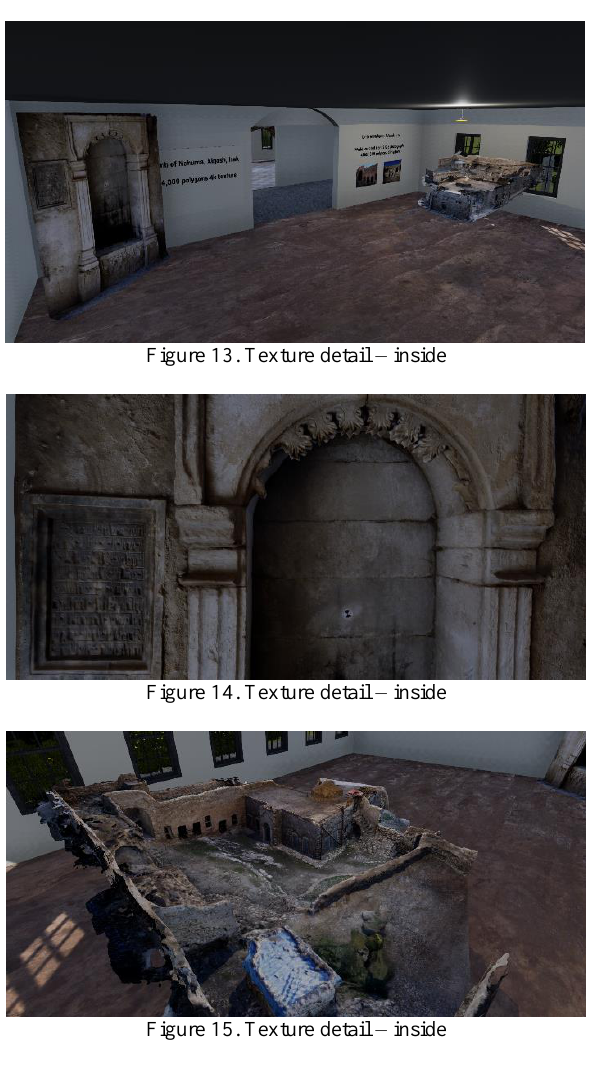
Figure 15. Texture detail –